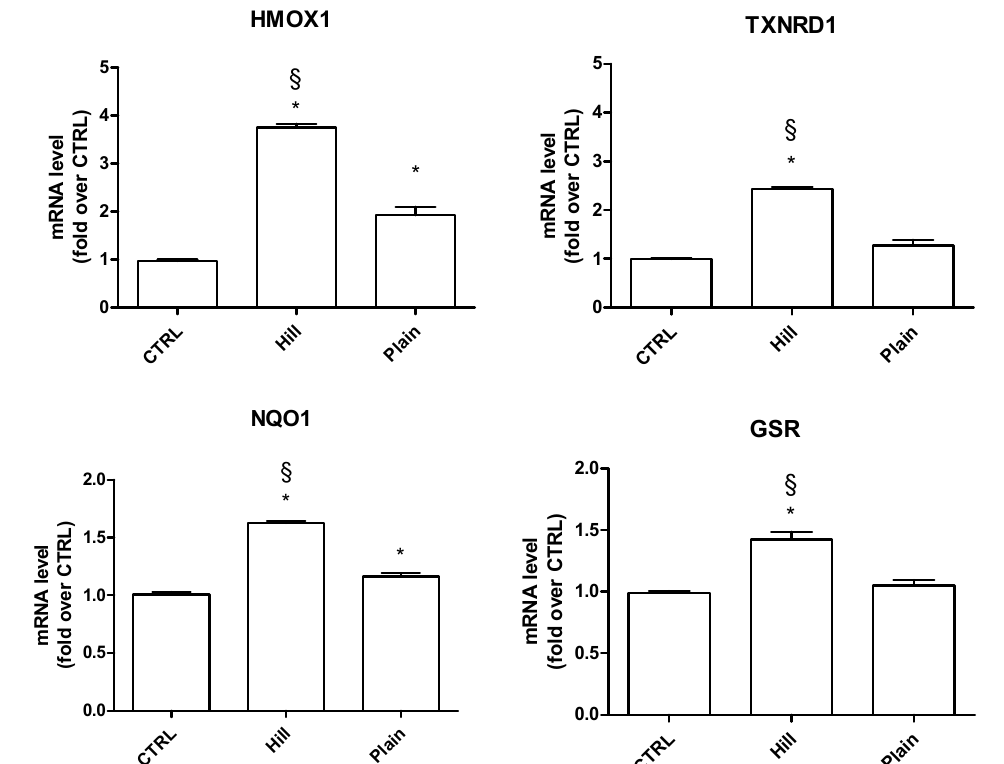
Figure 4. Expression of antioxidant enzymes in SH-SY5Y cells treated with the extracts. Cells were treated with hill and plain extracts (10 μ g/mL) for 6 h. Real time-PCR was performed to detect HMOX1, TXNRD1, NQO1 and GSR mRNA levels. Data are expressed as relative abundance compared to untreated cells. Each bar represents mean ± SEM of three independent experiments. Data were analyzed with a one-way ANOVA followed by the Bonferroni’s test. * p < 0.05 vs. CTRL; § p < 0.05 vs. plain.